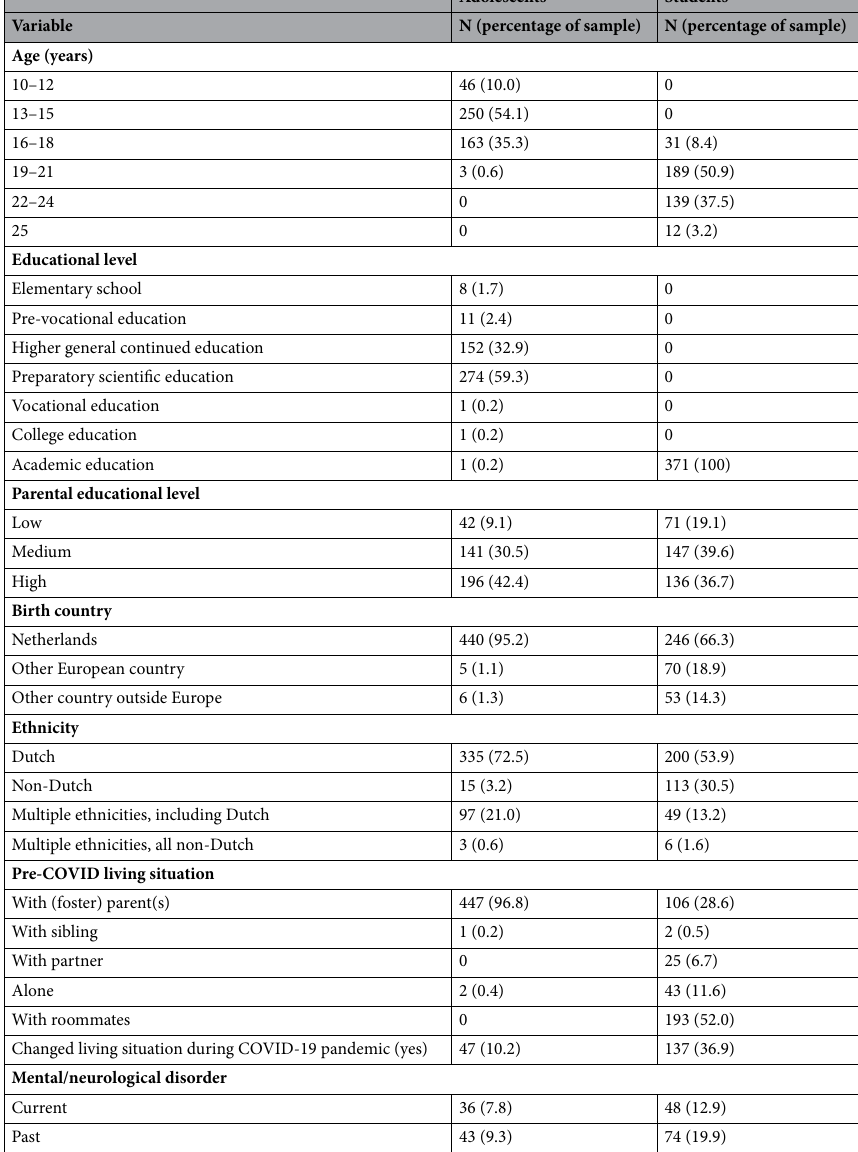
Table 1. Overview on the sample characteristics for the adolescents (N = 462) and the students (N = 371) in May 2020 (T1). Percentages do not necessarily add up to 100, due to missing data. Responses with “I do not know” were reported as missing